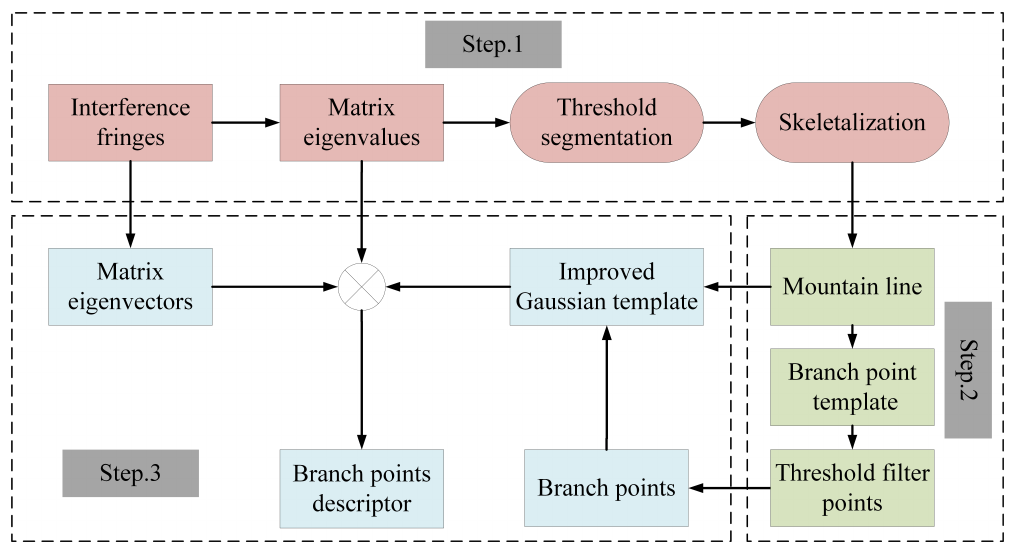
Figure 2. Algorithm